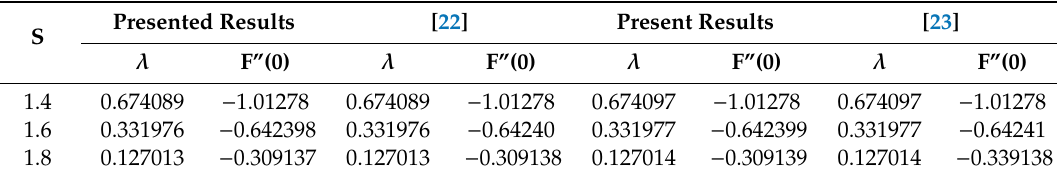
Table 6. Comparison with scientific literature for φ = 0, M = 0, a ∗ = 0, b =